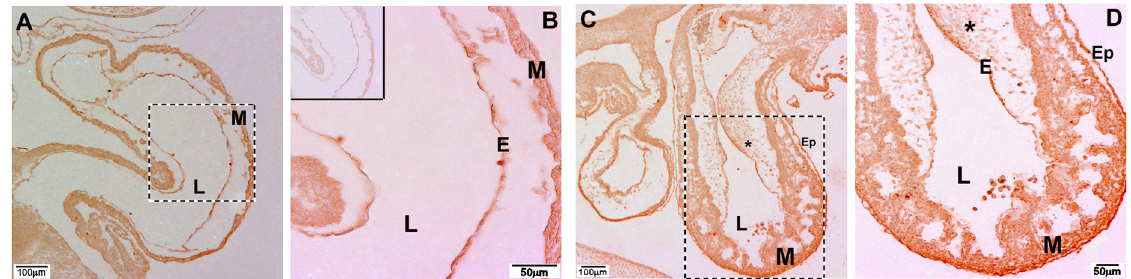
Figure 8. Immunofluorescent localization of β2 and β1 integrins in embryonic chicken heart. Immunostaining using Cy3-conjugat- ed secondary antibodies. Sections of stag- es HH17 (A) and HH20 (B) chicken hearts showing β2 integrin localization. C , β1 in - tegrin in stage HH20 heart. D , No staining was detected when the primary antibody was omitted from the staining protocol. E = endothelium; L = lumen; M = myocardium; * = mesenchymal cells. Magnification bars = 50